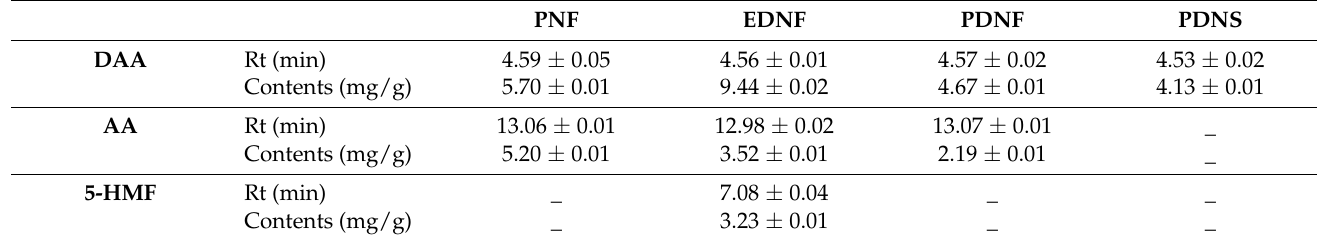
Figure 1. ( A ) Chromatograms of noni fruit and seed substances; ( B ) the structures of the major constituents. The reveled signals on chromatograms were detected at 245 nm. Table 1. Contents of the major constituents in noni fruit and seed substances.